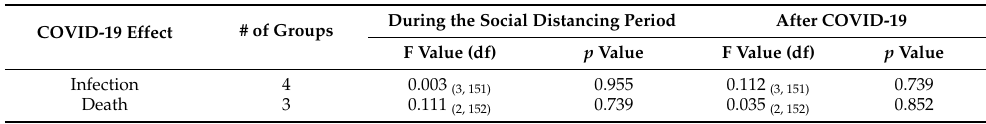
Table 5. The effect of COVID-19 on participants’ trends toward e-commerce and